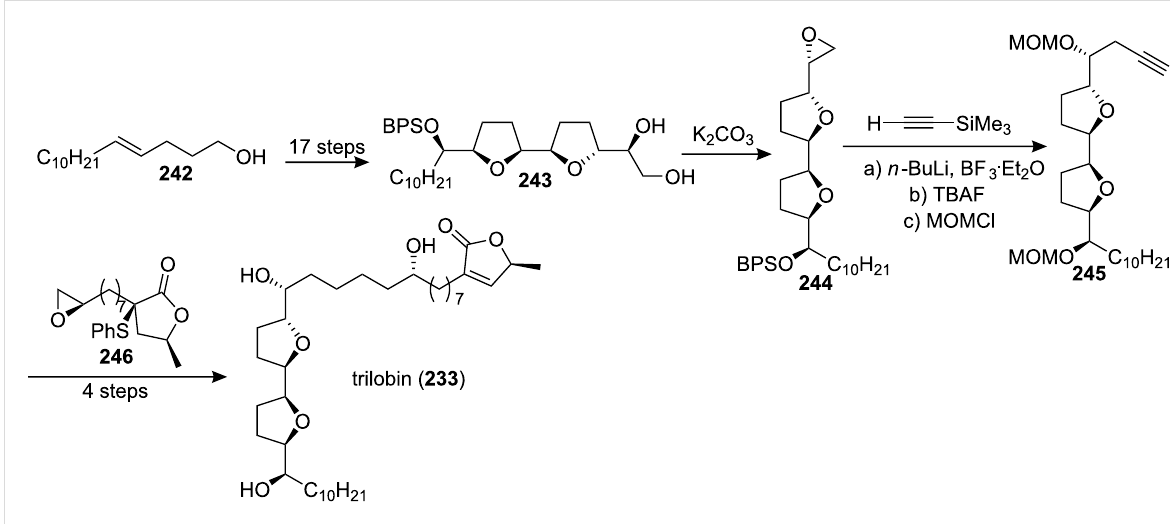
Scheme 33: Total synthesis of trilobin by the group of Sinha and Keinan.